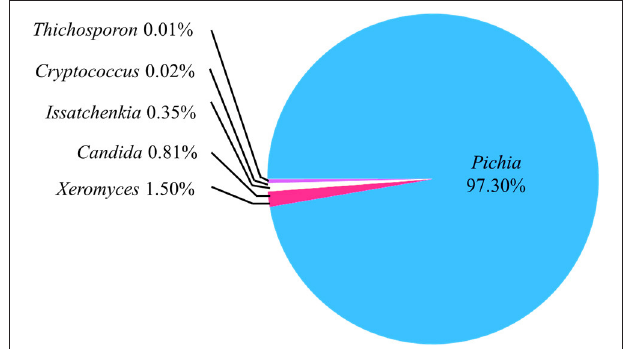
FIGURE 3 | Enumeration of lactic acid bacteria (LAB) in the Suanzhou samples.